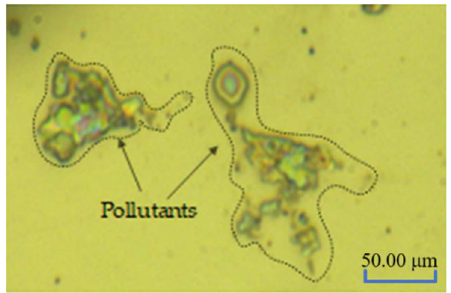
Figure 5. Surface contamination after processing.